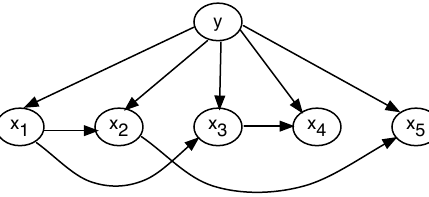
Figure 2. Example of the TAN